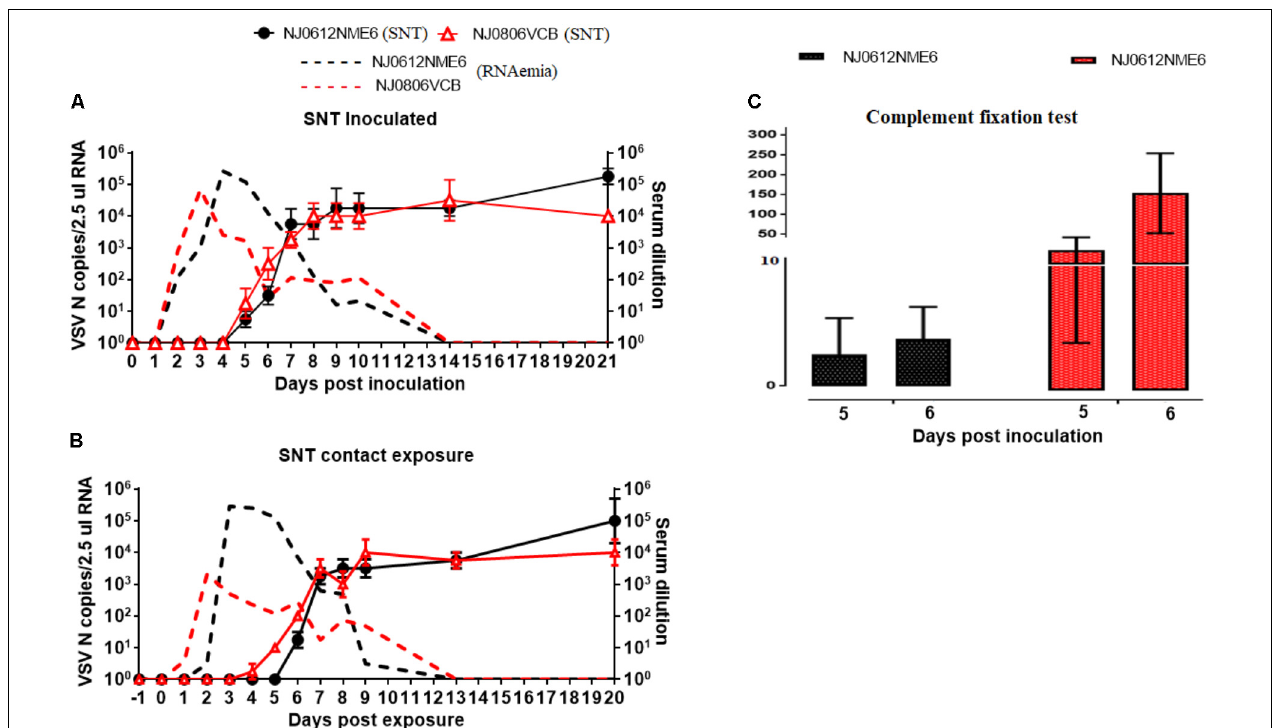
FIGURE 13 | Adaptive immune response. Serum neutralization antibody titers following infection with NJ0612NME6 or NJ0806VCB. Adaptive immune response was monitored by measuring anti-VSV antibodies in serum collected at indicated the time points in (A) inoculated or (B) contact pigs. The broken lines in black and red represent levels of viral RNA in the blood of pigs infected with NJ0612NME6 and NJ0806VCB, respectively, indicating a negative correlation between antibody immune response and RNAemia phase. (C) The early antibody response in infected pigs with different viruses was evaluated by complement fixation